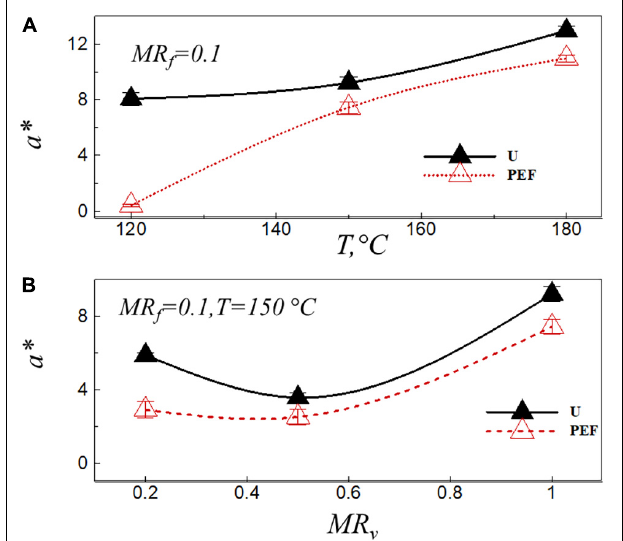
FIGURE 3 | Value of chromatic parameter a ∗ after frying, MR f = 0.1, vs. the frying temperature (A) , and the moisture ratio after VD (B) for untreated (U) and PEF pre-treated samples